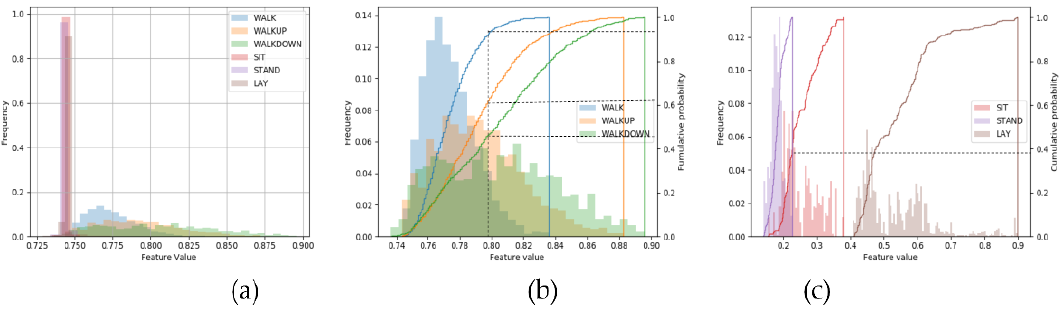
Figure 2. The feature values between different categories. ( a ) Shows the different distributions of a certain feature value between static classes and dynamic classes. ( b ) Displays the data distribution and cumulative probability of a certain feature on the dynamic class and ( c ) shows that on the static class.